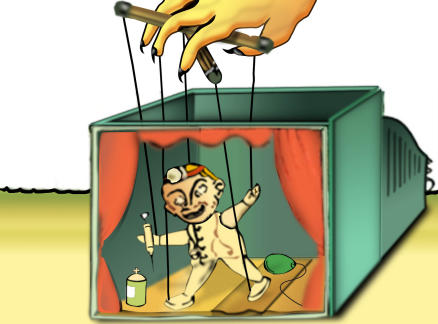
(Illustration: Luis Chan Chan)